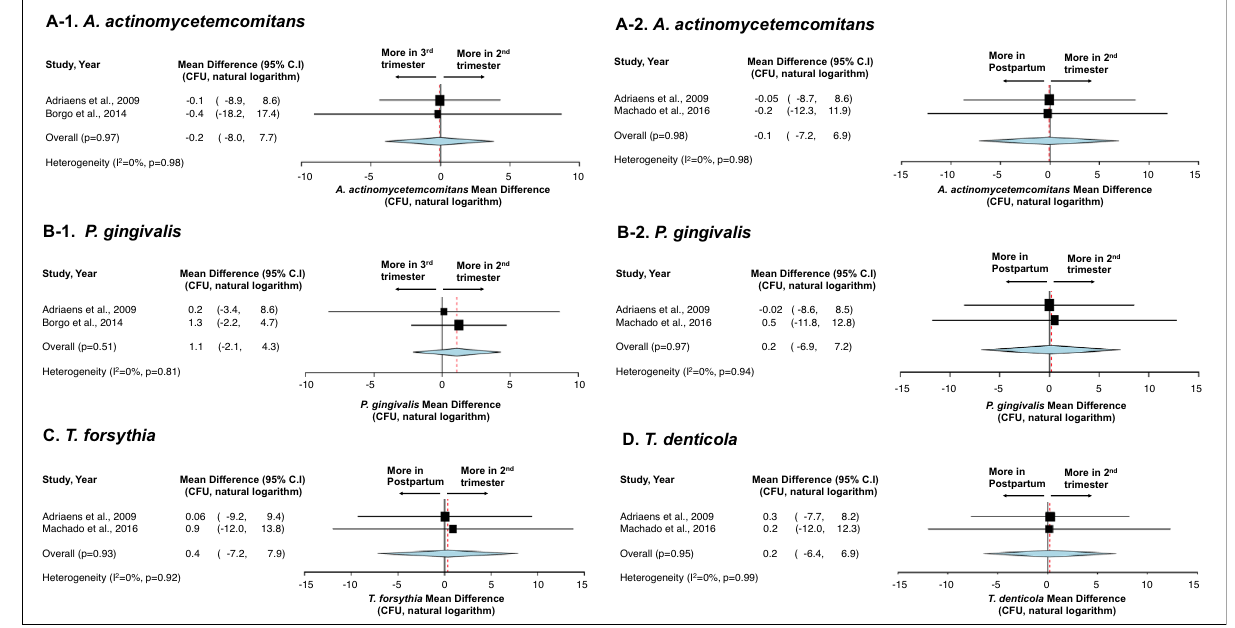
Figure 5. Impact of pregnancy status on the carriage of periodontal pathogens in subgingival plaques. ( A ) Carriage of A. actinomycetemcomitans during pregnancy trimesters ( A-1 ) and between pregnancy and postpartum ( A-2 ). ( B ) Carriage of P. gingivalis during pregnancy trimesters ( B-1 ) and between pregnancy and postpartum ( B-2 ). ( C ) Carriage of T. forsythia between postpartum and 2nd trimester. ( D ) Carriage of T. denticola between postpartum and 2nd trimester. Study heterogeneity (I 2 ) and the related p value were calculated using the continuous random effect methods. The Mean Difference, 95% CI of each study included in the meta-analyses and forest plots of comparisons shown in ( A – D ) indicate that, regarding the carriage [measured by colony forming unit (CFU)] of four different periodontal pathogens in subgingival plaque, there is no statistically significant difference between stages of pregnancy and between postpartum and pregnancy (p >